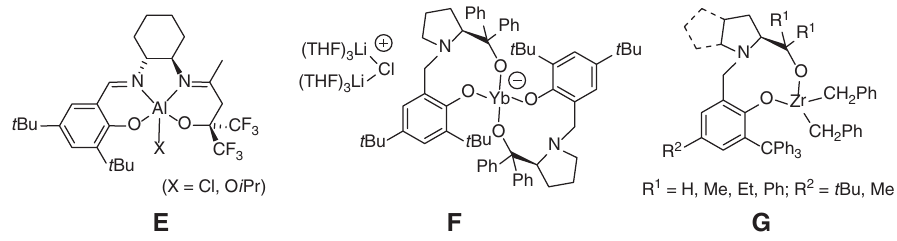
Figure 2: Examples of complexes bearing mixed phenolate/alcoholate dianionic ligands.